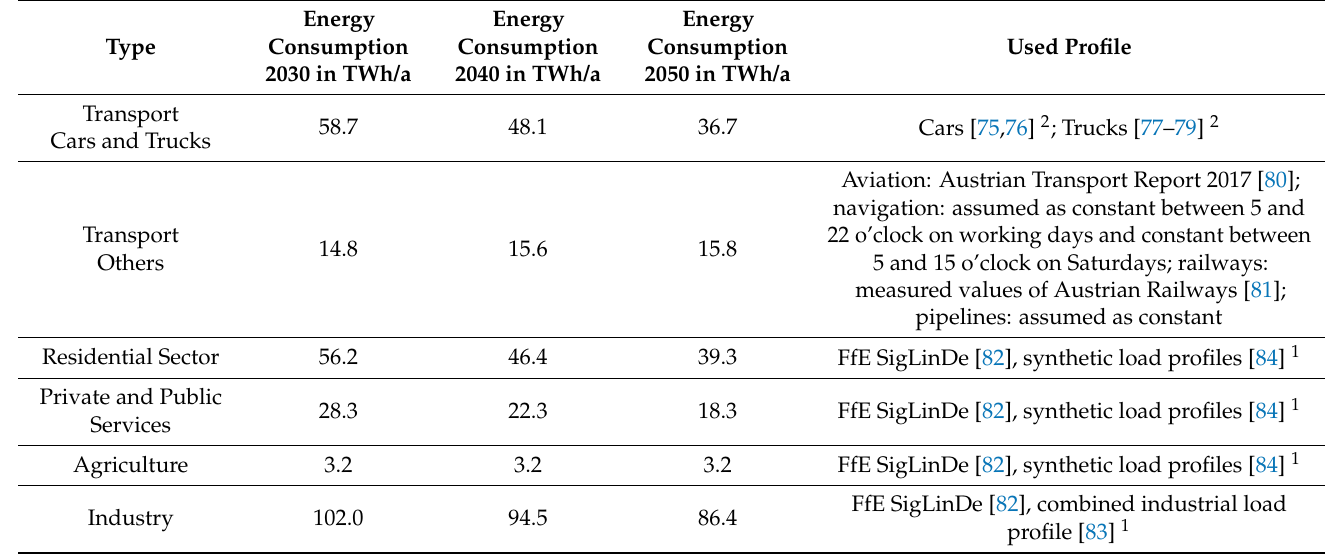
Table A10. Final energy consumption for the scenario Sufficiency final energy (calculation based on [40]).